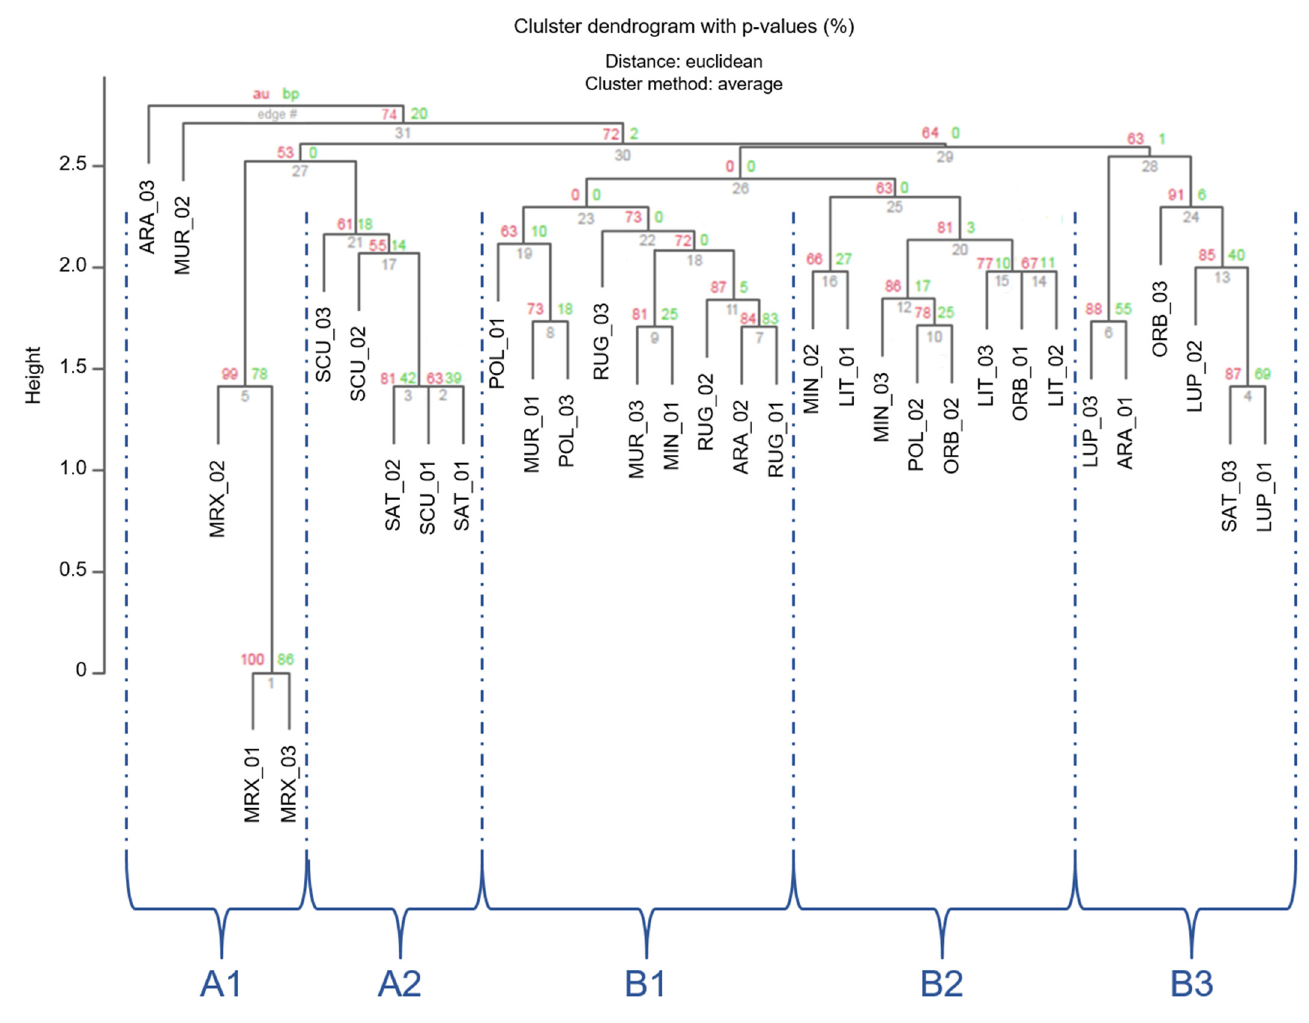
Figure 6. Cluster dendrogram of individuals based on the Euclidean distances. Values at branches are AU p -values (red) and Bootstraps BP-values (green), based on cp-SSRs.